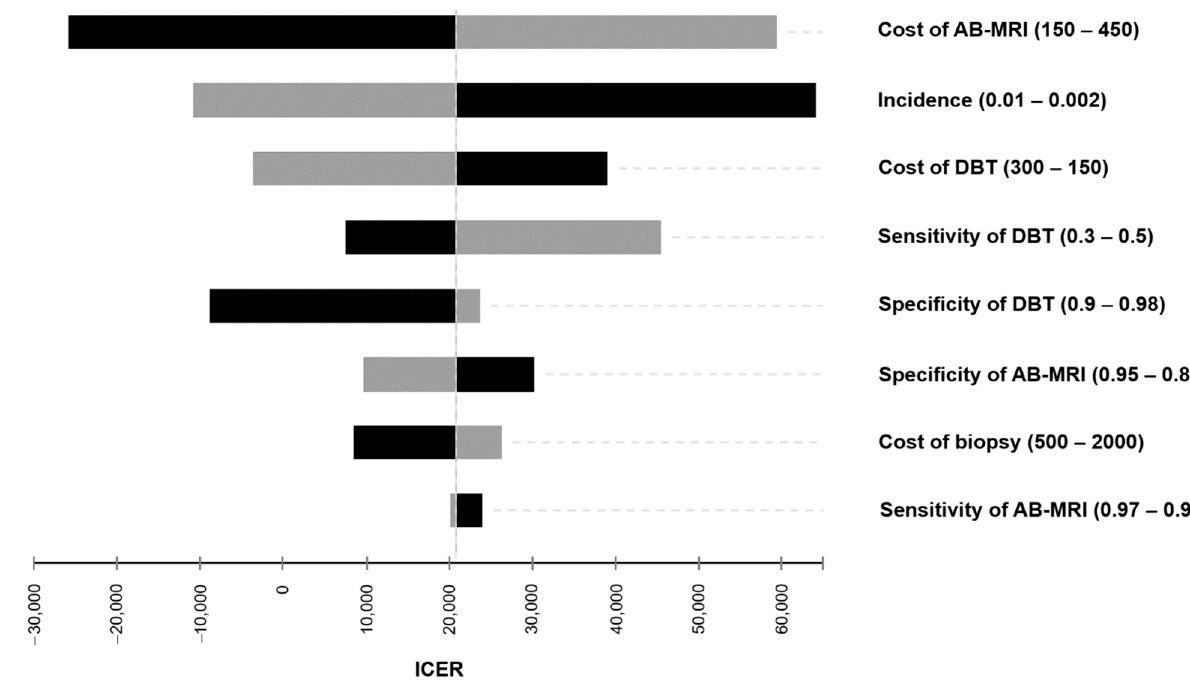
Figure 1. Tornado diagram of the one-way sensitivity analysis. Input parameters were varied within a reasonable range to indicate their impact on the incremental cost-effectiveness ratio (ICER) in US-$ per QALY gained.